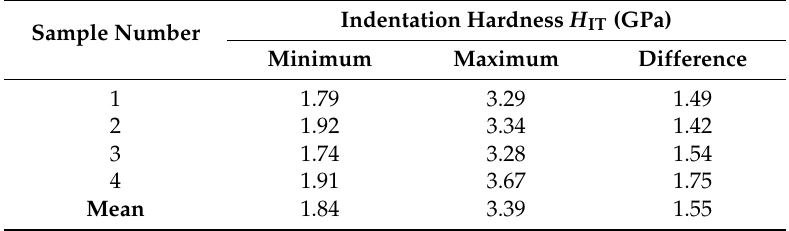
Table 3. Minimum and maximum values of the indentation hardness H IT of micro samples after the heat treatment in DSC with a heating rate of 10